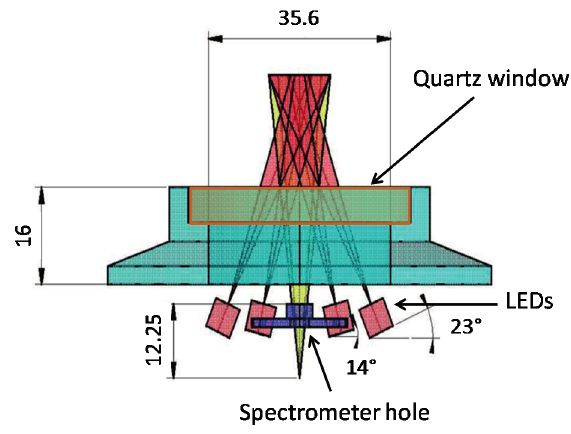
Figure 2. The water region observed by the spectrometer is illuminated by the UV and blue LEDs. Water and optoelectronic devices are separated by a quartz window (NHI-1191 by Helios Italquartz, Milan/Italy) with transmittance greater than 90%.